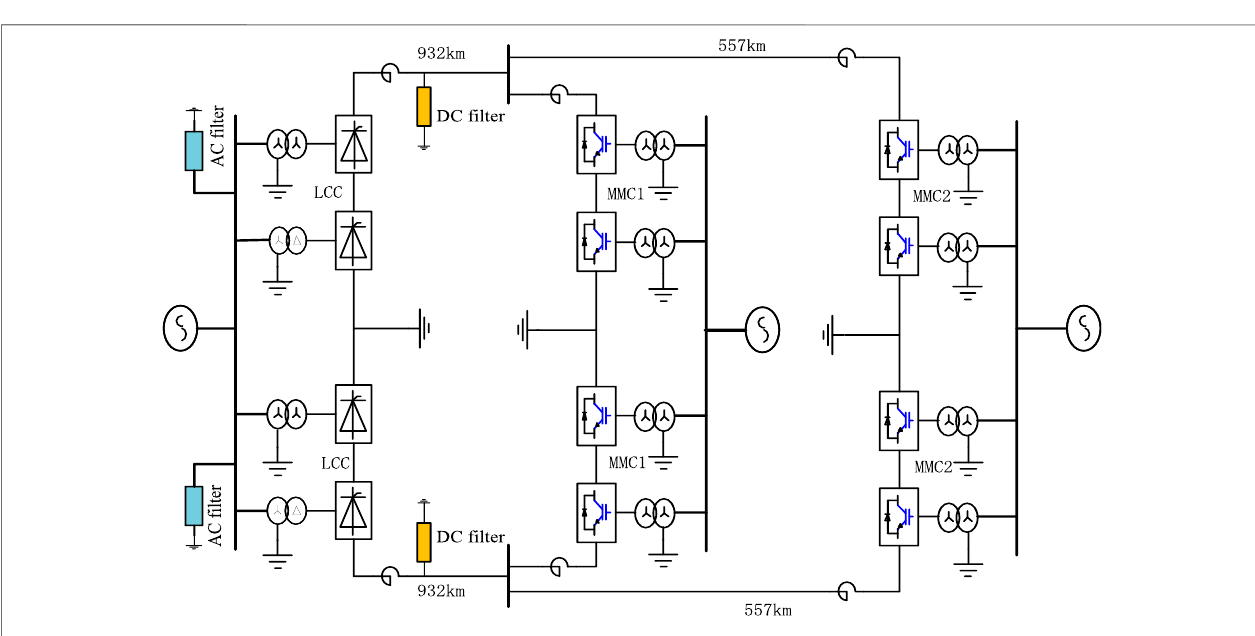
FIGURE 8 | Simulation model of the Wudongde transmission project.